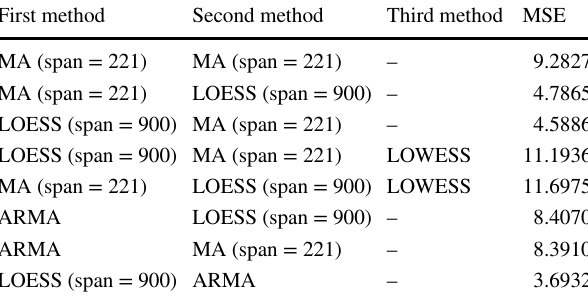
Table 3 Calculated MSE of various combined smoothing methods for pressure signal with 2% noise